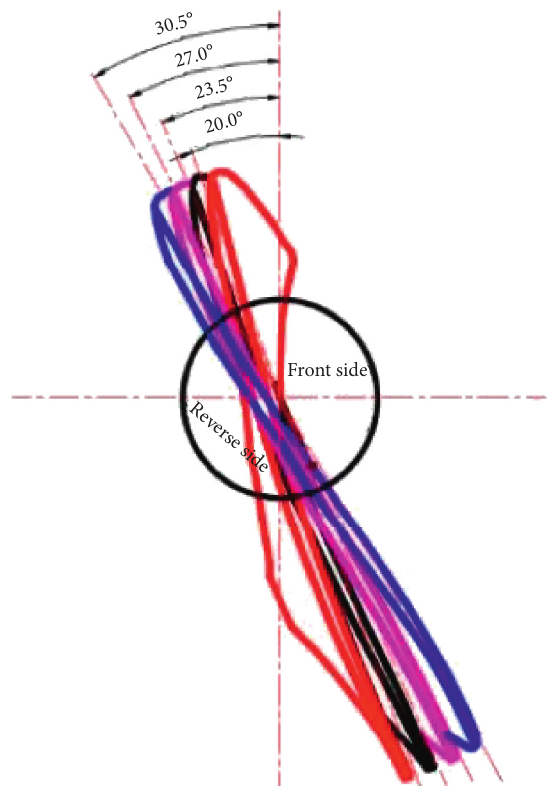
Figure 3: Schematic diagram of blade relative torsion